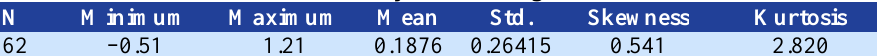
Table 1. Results of statistical analysis on Langelier saturation